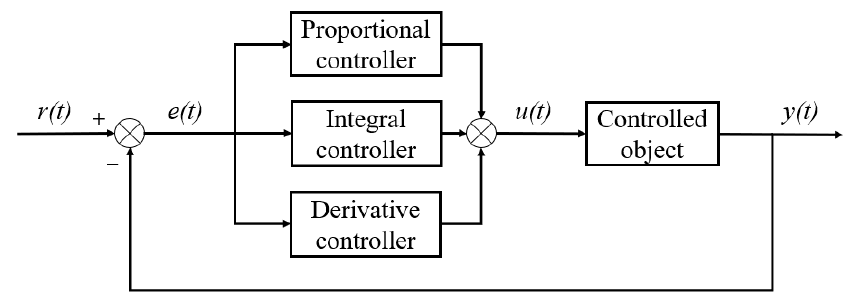
Figure 3. PID control structure diagram.